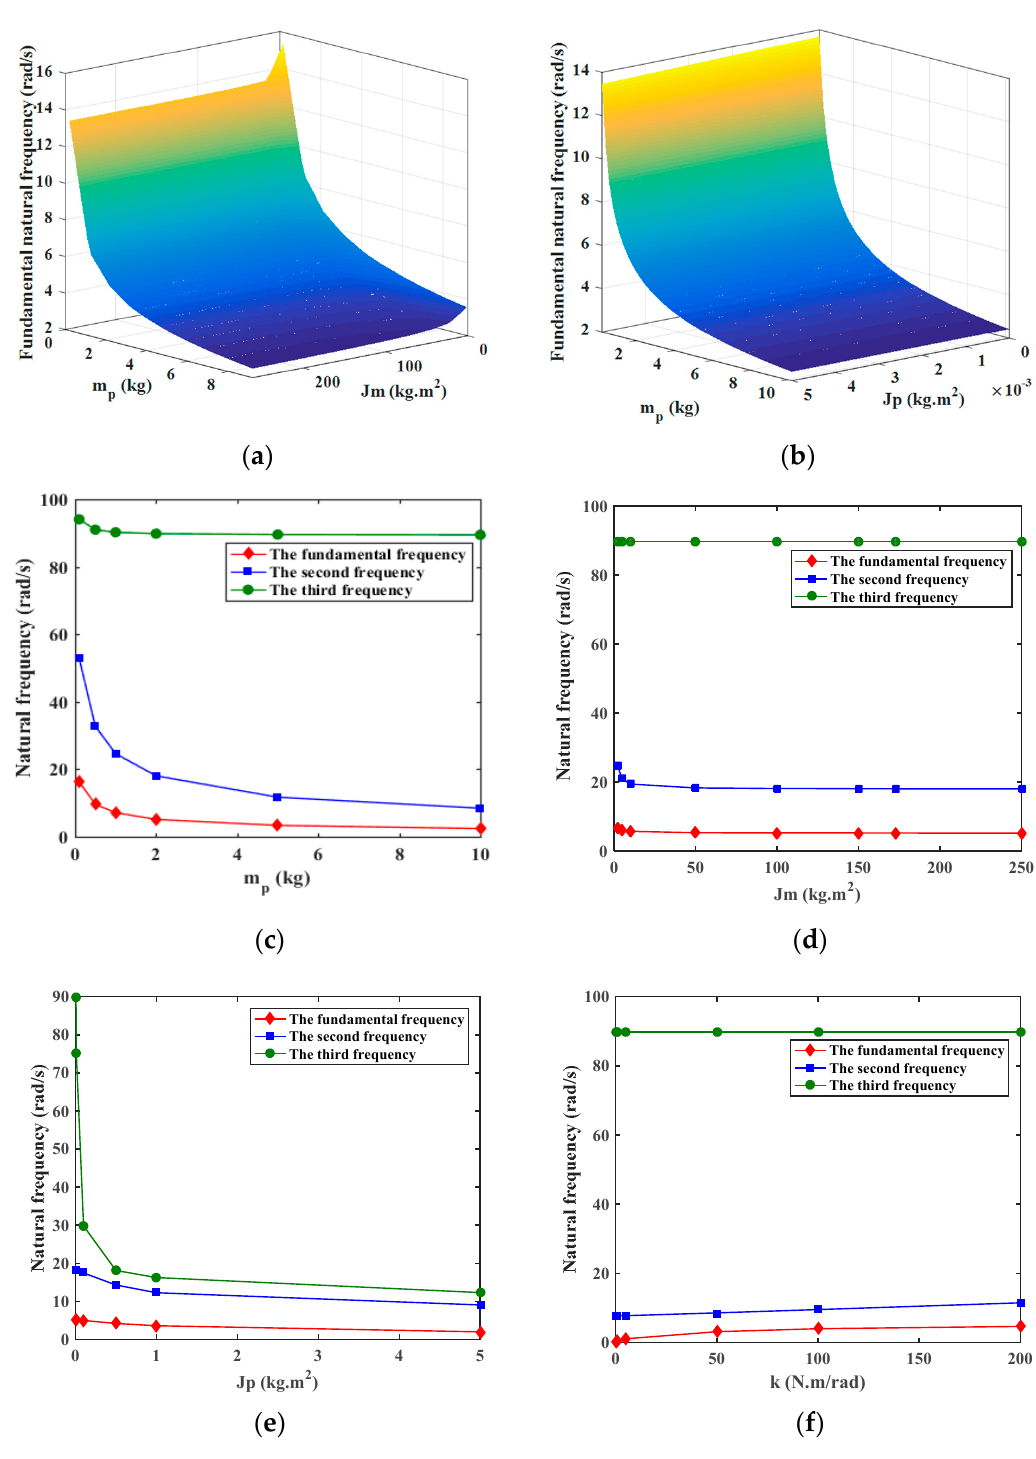
Figure 7. Sensitivity of parameters on natural frequencies of the SFF system: ( a ) effect of both the payload mass and motor inertia; ( b ) effect of both the payload mass and payload inertia; ( c ) effect of the mass of the tip payload; ( d ) effect of motor inertia; ( e ) effect of the moment inertia of the tip payload; ( f ) effect of the stiffness of the flexible joint.